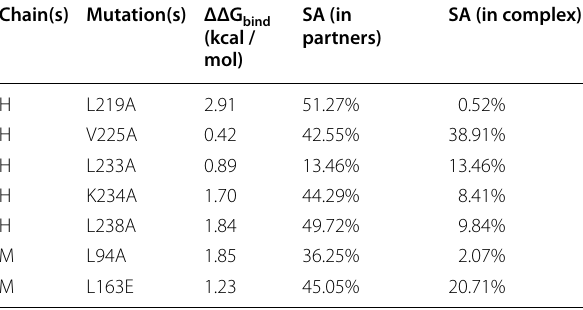
Table 2 BeAtMuSiC-predicted change in binding affinity as a result of